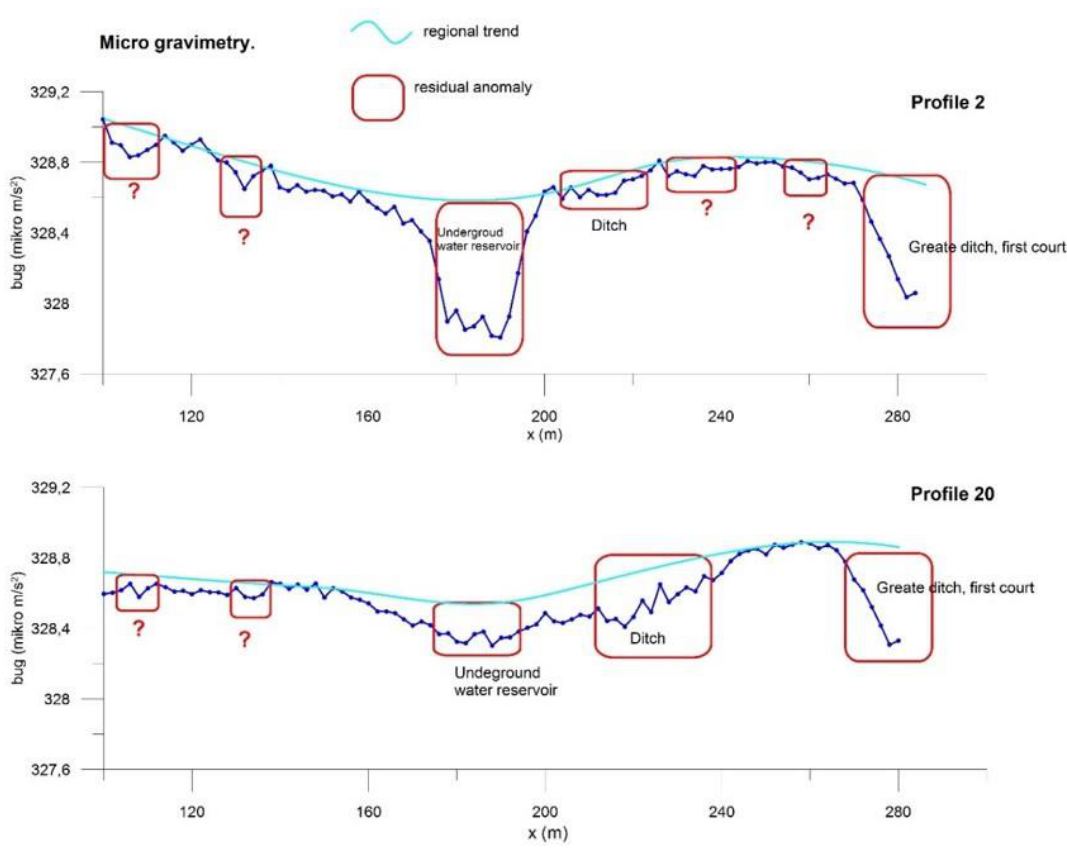
Figure 22. Hradčany Square. Graphs of residual Bouguer anomalies. Profiles in direction W-E.